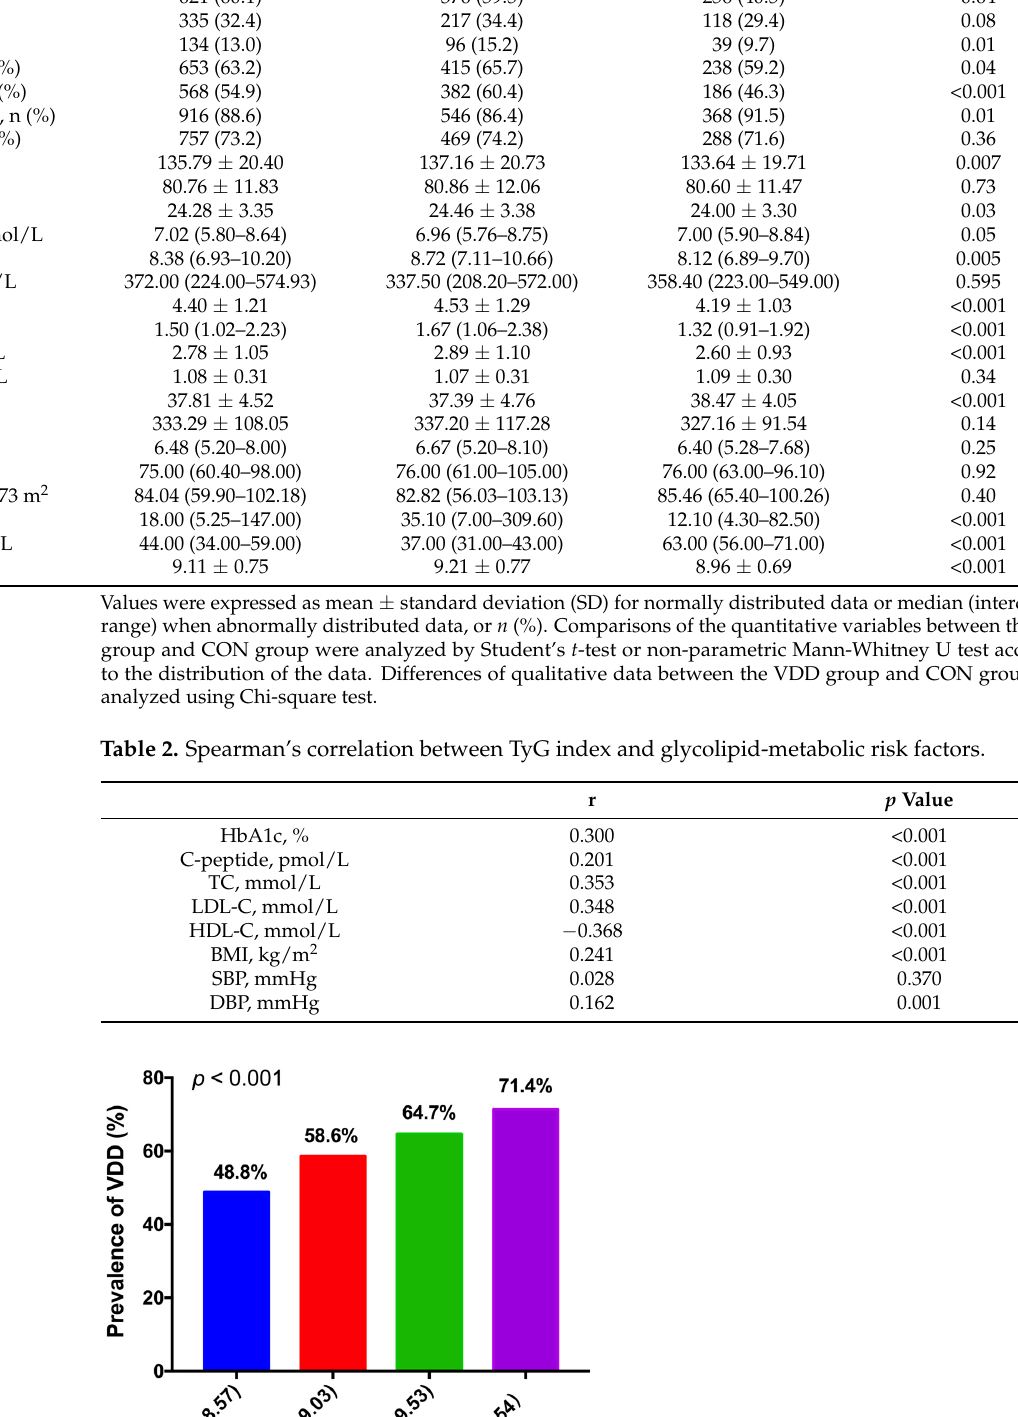
Table 1. Baseline characteristics of the participants based on vitamin D levels.